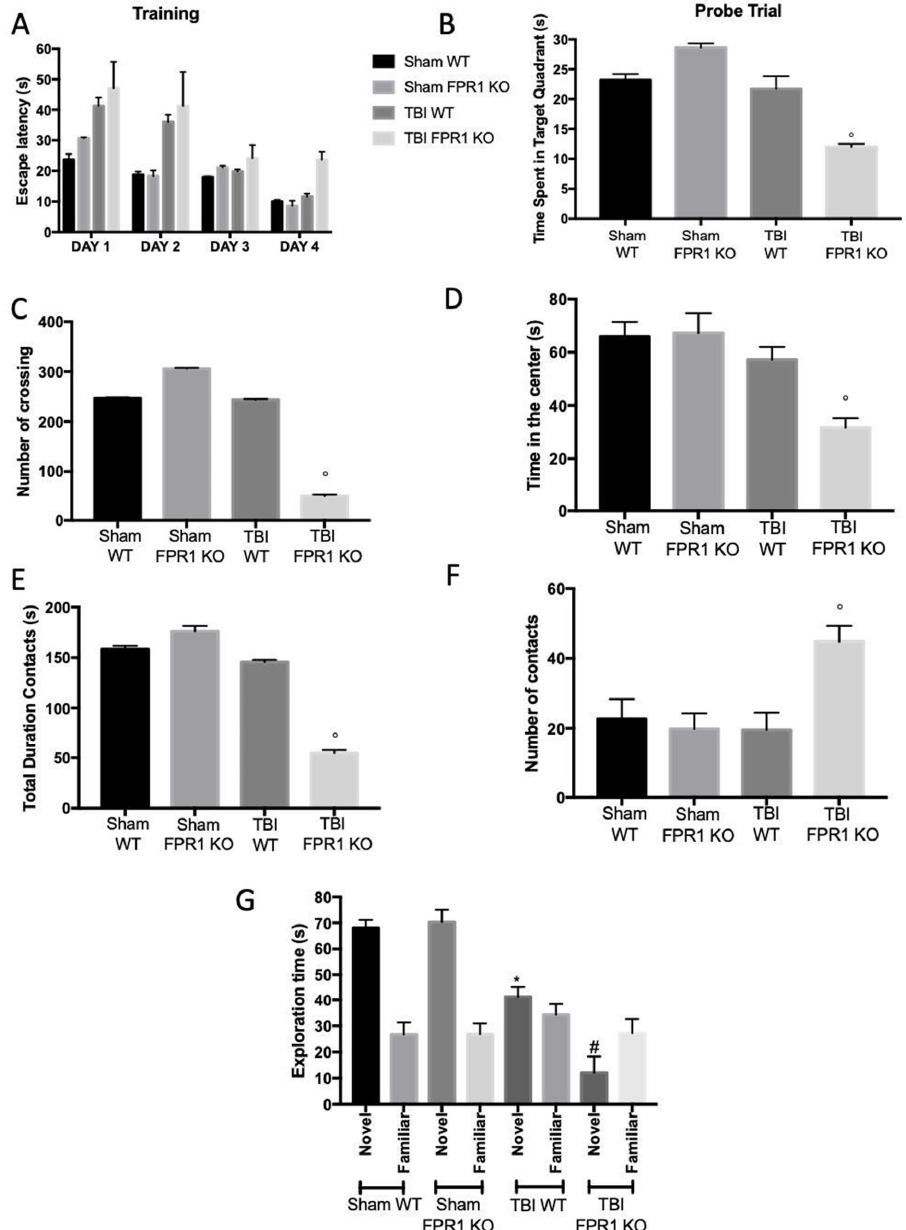
Figure 14. Effect of the absence of Fpr1 on behavioral tests: Training and Probe trial of the Morris water maze performed four weeks after injury shows that the TBI Fpr1 KO group takes a longer time than the TBI WT group to find the hidden platform ( A , B ) In the Elevated Plus Maze test performed four weeks after injury, the TBI Fpr1 KO mice spend significantly less time in the open arm and in the central zone than WT animals ( C , D ). In the social interaction test we observed that the total duration of the contacts was decreased in the TBI Fpr1 KO animals compared to the TBI WT group, while the number of contacts was significantly increased in the TBI Fpr1 KO animals compared to the TBI WT group ( E , F ) In the novel object recognition test, the Fpr1 KO animals subjected to traumatic brain injury spend significantly less time with the novel object, while in the TBI WT mice the function within the novel object recognition test returned to normal values ( G ). For the analyses, n = 5 animals from each group were employed. Results were analyzed by two-way ANOVA followed by a Bonferroni post-hoc test for multiple comparisons. Non-parametric data were analyzed with Fisher’s exact test. * p < 0.05 vs. Sham WT; ◦ p < 0.05 vs. TBI WT; # p < 0.05 vs. TBI